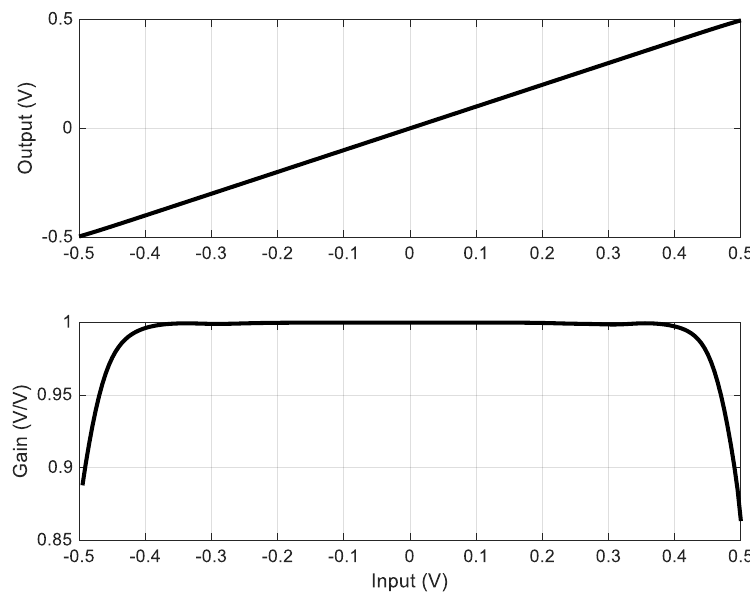
Figure 7. Closed-loop large-signal input/output characteristic and gain.